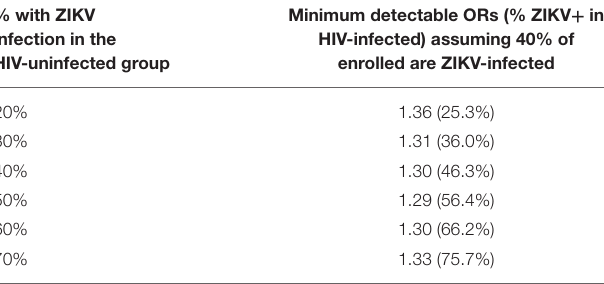
TABLE 2 | Minimum detectable odds ratios (ORs) (and percent of ZIKV-infected among HIV-infected) at 80% power for various assumed ZIKV infection rates among HIV-uninfected.